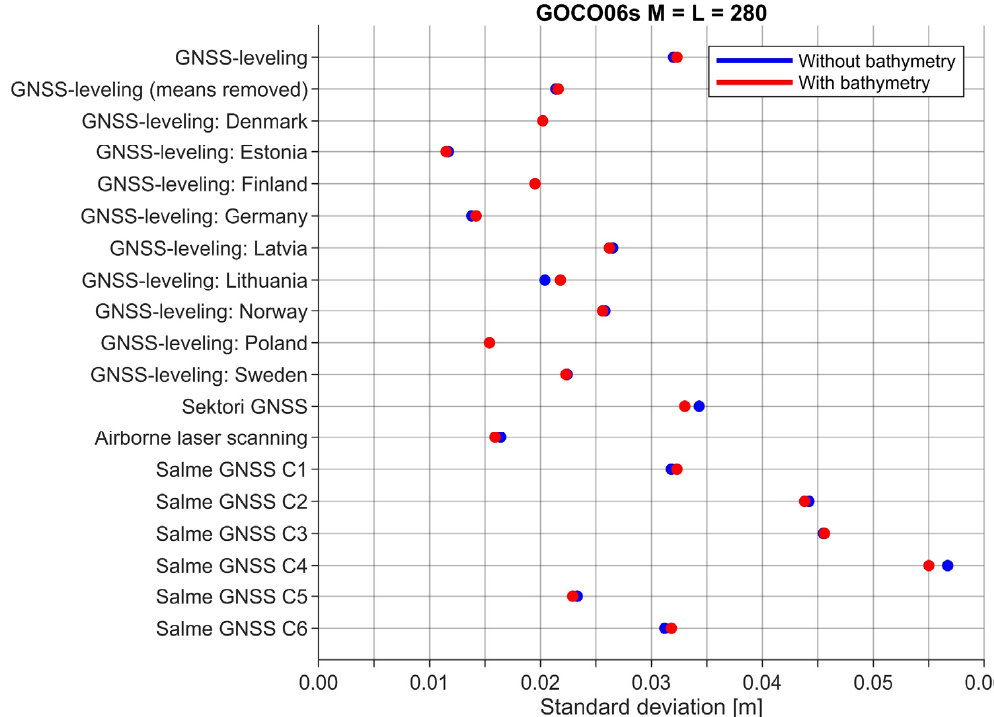
Figure 18. Validation results of gravimetric geoid models. GGM: GOCO06s, modification limits: 280.